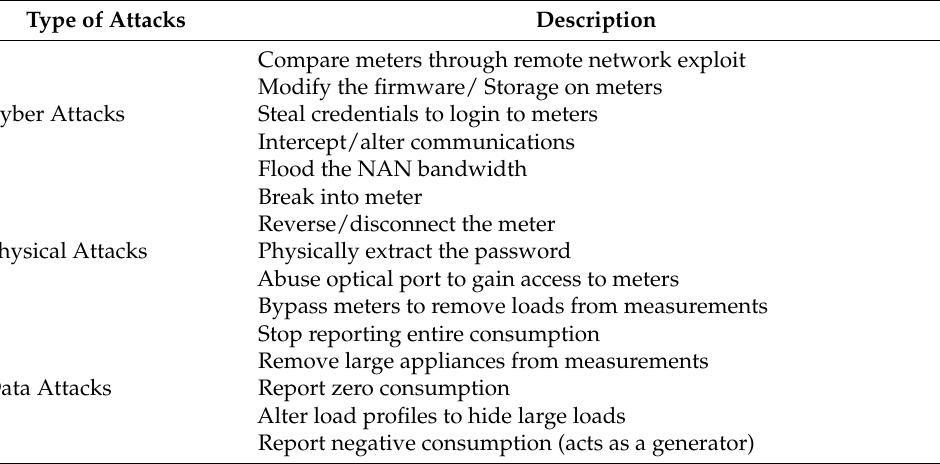
Table 1. Threat classified by different detection